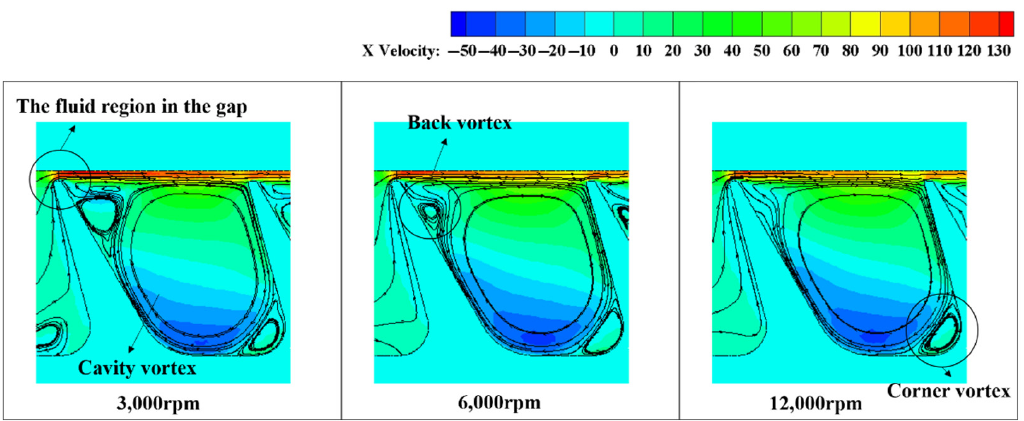
Figure 7. Labyrinth cavity eddies at various rotation velocities.